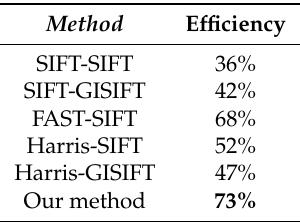
Figure 20. An image pair from the “VPrice dataset”. Table 3. Results (matching ratio) on VPrice